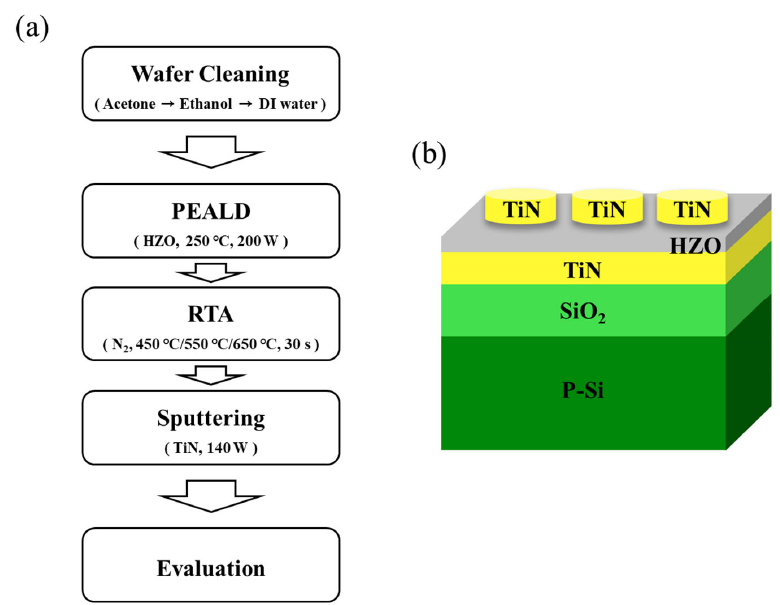
Figure 1. Schematics of ( a ) MFM device production and ( b ) MFM device structure.